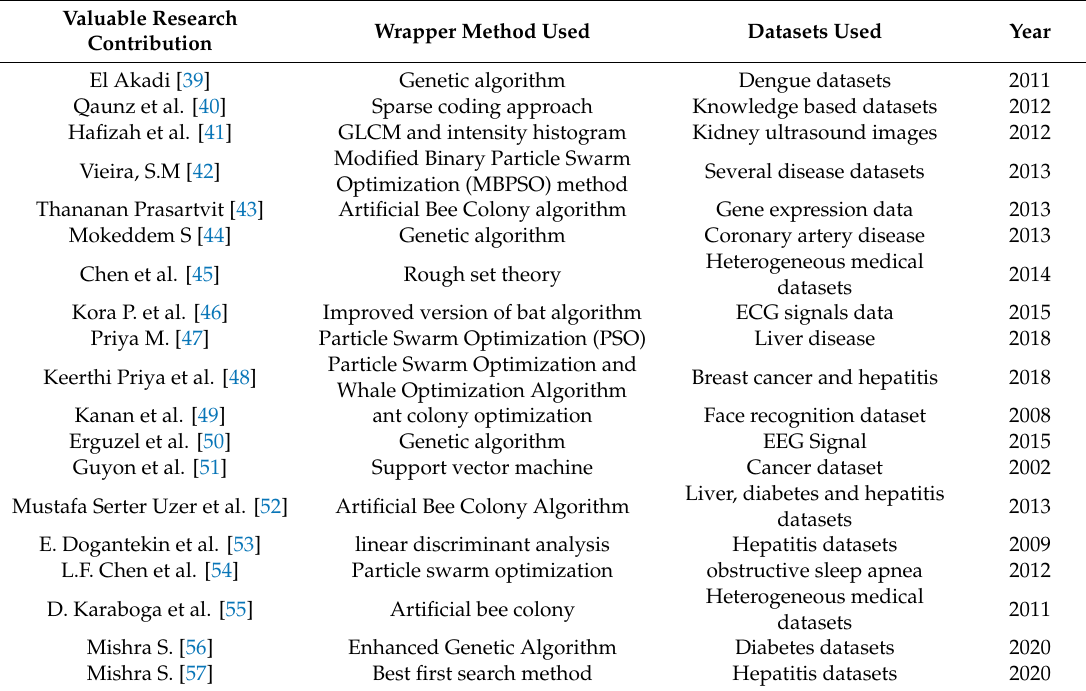
Table 1. An outline of relevant study on wrapper based attribute selection.